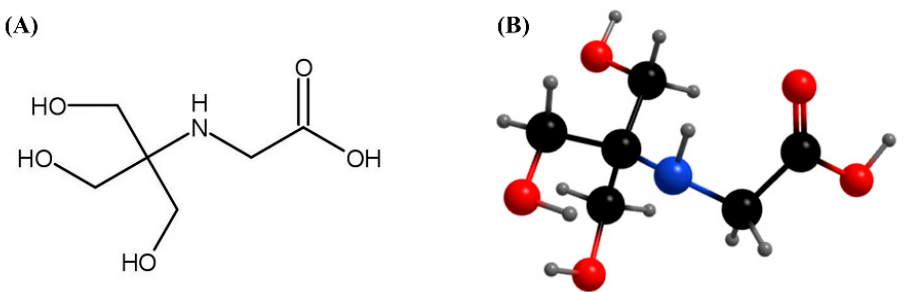
Figure 1. The 2D ( A ) and 3D ( B ) molecular structure of tricine.